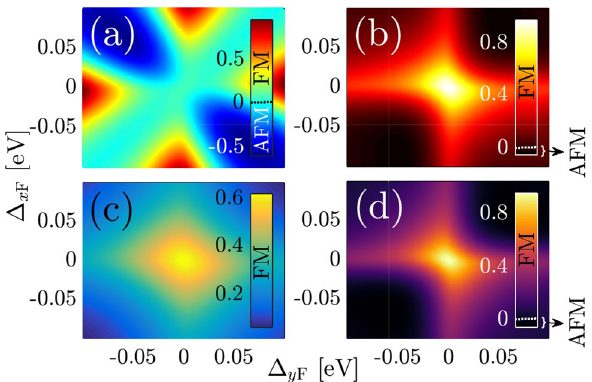
4 , to the ferroelectric 10 − × 6 50 Å , ϕ R and ( b ) R = π/ } { =